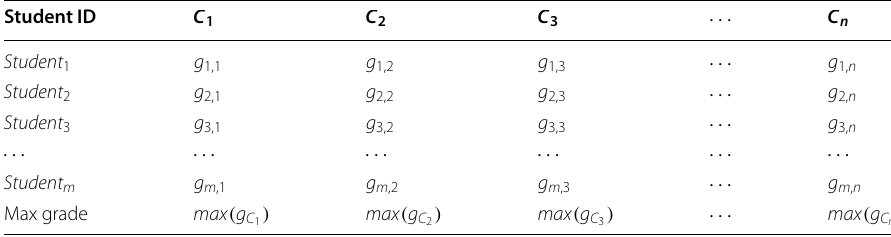
Table 2 Example of student performance file that the model takes as